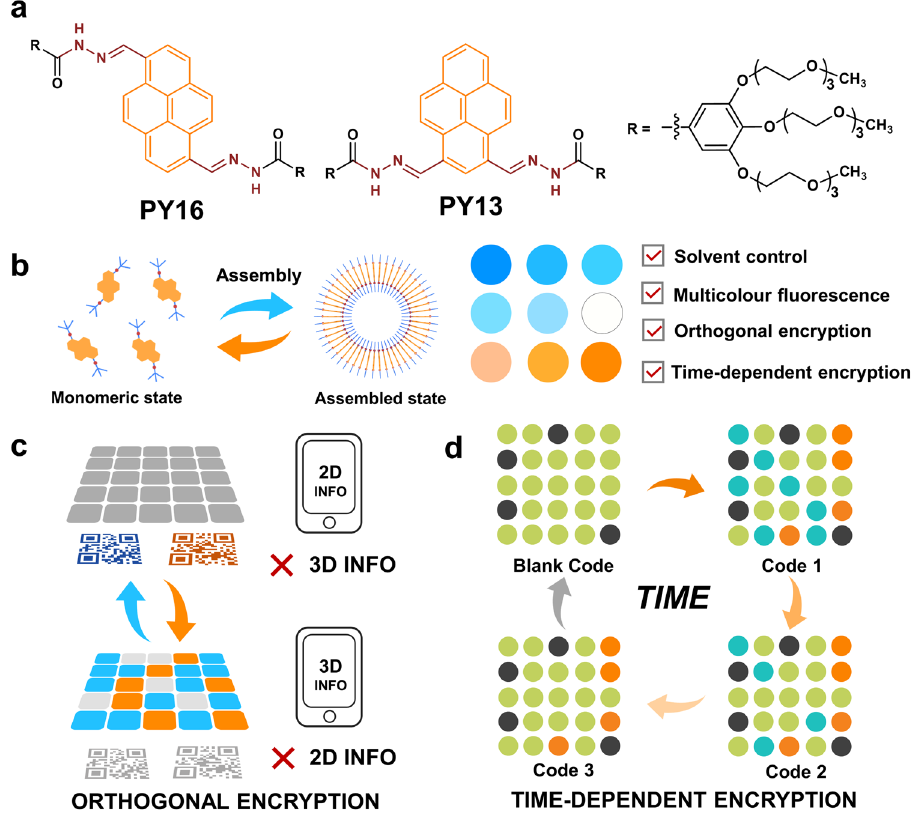
Fig. 1 The construction of a dynamic assembly-induced emissive system and advanced information encryption material with time-dependent security. a Molecular structures of two compounds. b Dynamic self-assembly and resultant multicolour fl uorescence. c 3D code and d 4D code for information